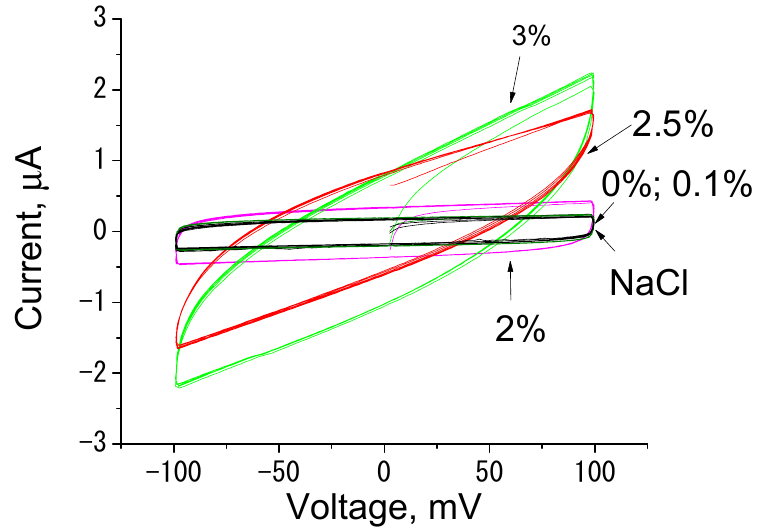
Figure 10. Cyclic voltammograms of chitosan/SWCNT composite films obtained in physiological solutions. The numbers denote weight percentages of SWCNT in composites. NaCl: cyclic voltammogram of electrodes of the measuring cell filled with electrolyte in the absence of the film.